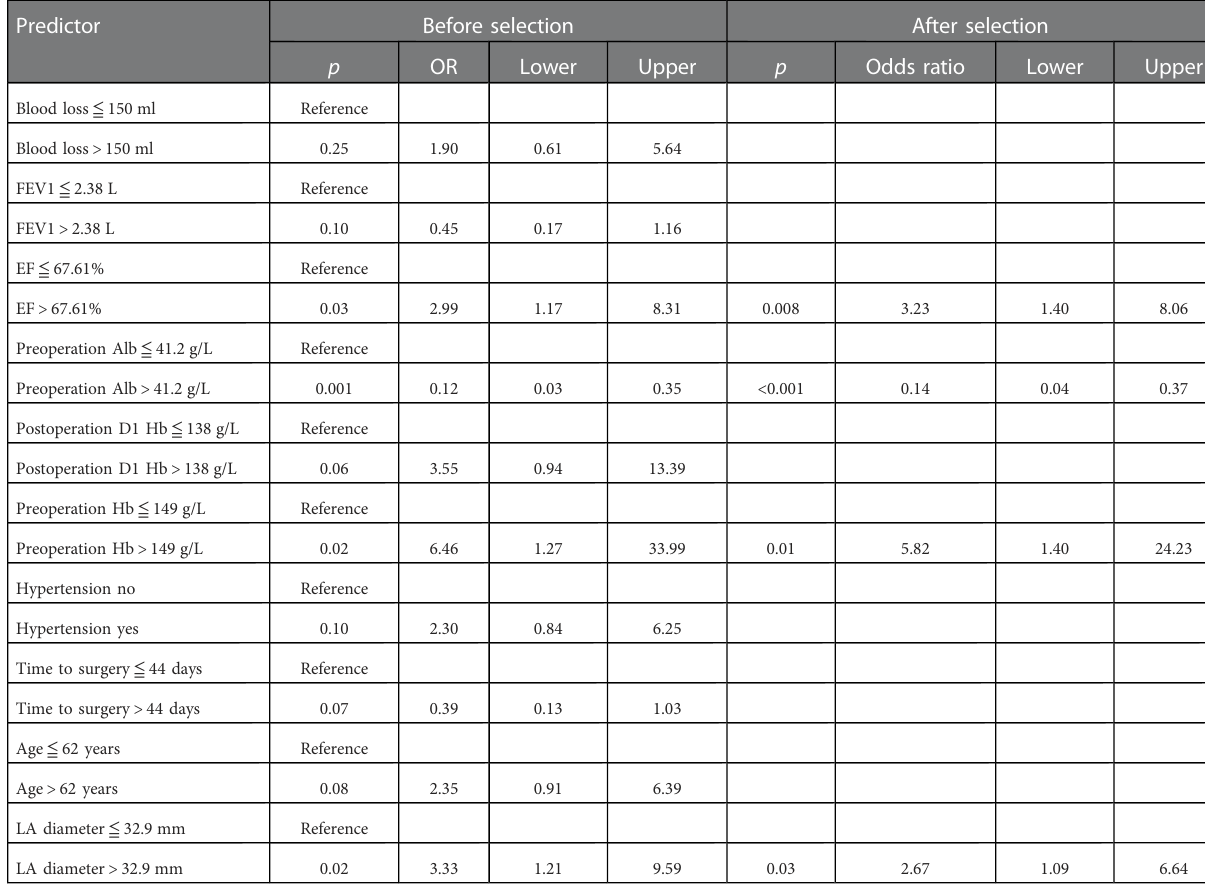
TABLE 3 Multivariate logistic analysis of postoperative atrial fi brillation.